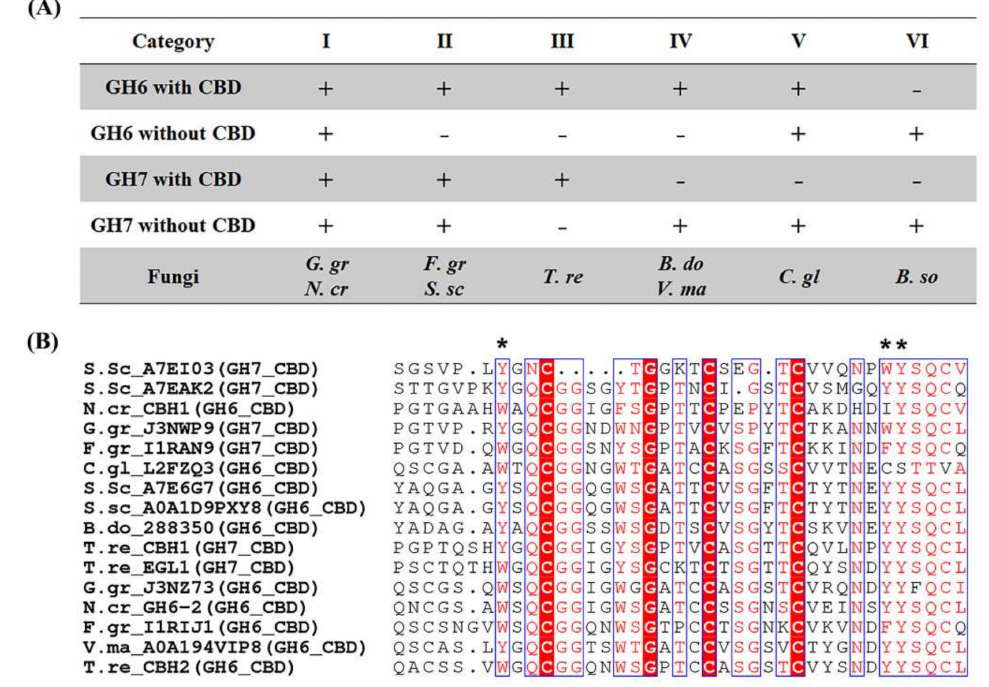
Figure 5. CBD organization and sequence alignment. ( A ) Categorization of CBD organization in GH6 and GH7 cellulases from the pathogenic fungi tested. + and − indicate cellulases with and without CBD, respectively. ( B ) Sequence alignment of CBDs in GH6 and GH7 enzymes. Red color highlights conserved residues. Black stars (*) are aromatic residues in the planar surface of CBD involved in cellulose